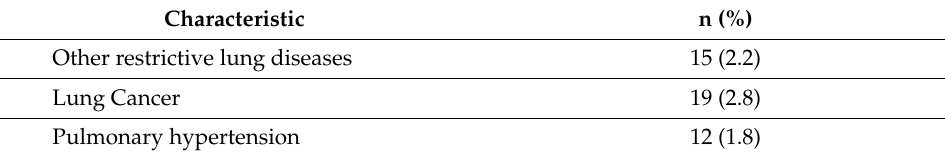
Table 1. Cont. Characteristic n (%) Other restrictive lung diseases 15 (2.2) Lung Cancer